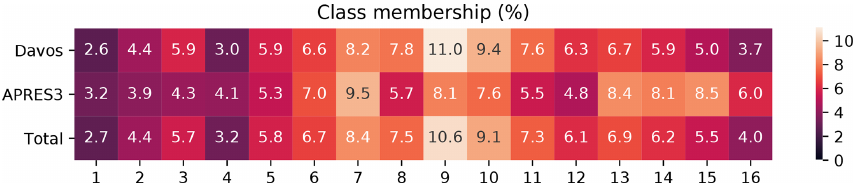
Figure 7. A heatmap showing the percentage of class memberships in each class for the Davos and APRES3 data as well as the entire dataset.